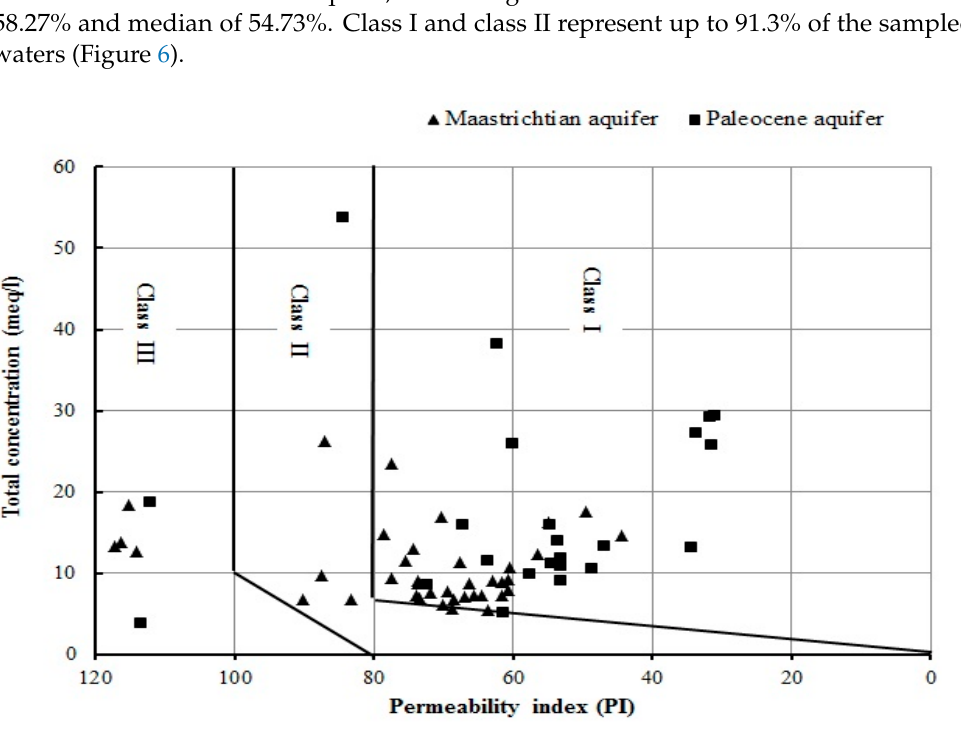
Figure 6. Doneen’s chart for the permeability index for the Maastrichtian and Paleocene samples.